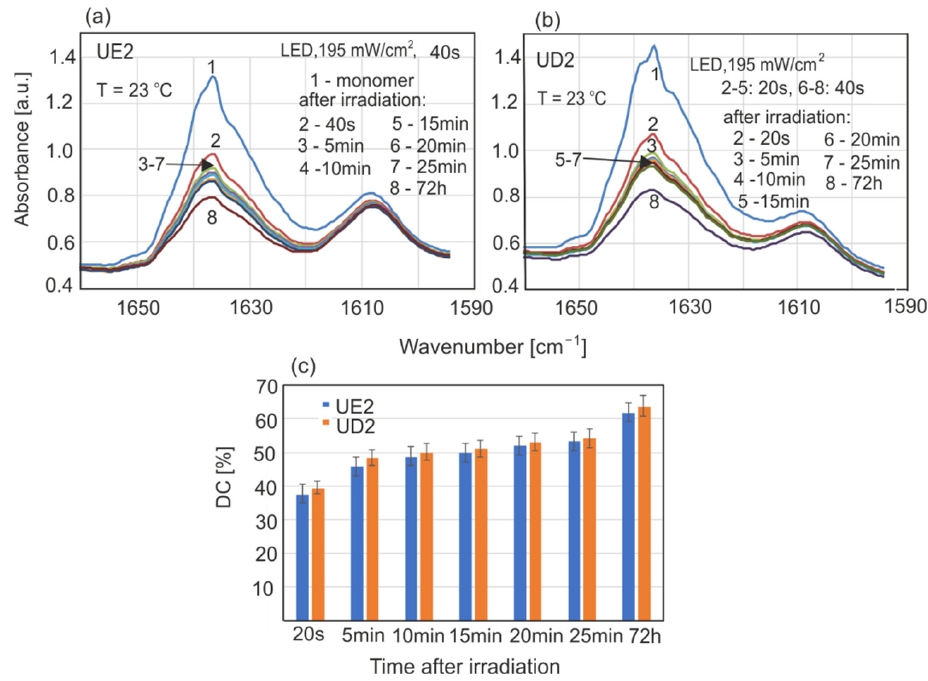
Figure 9. Changes in resin absorption during polymerization after irradiation with an LED at 23 °C: